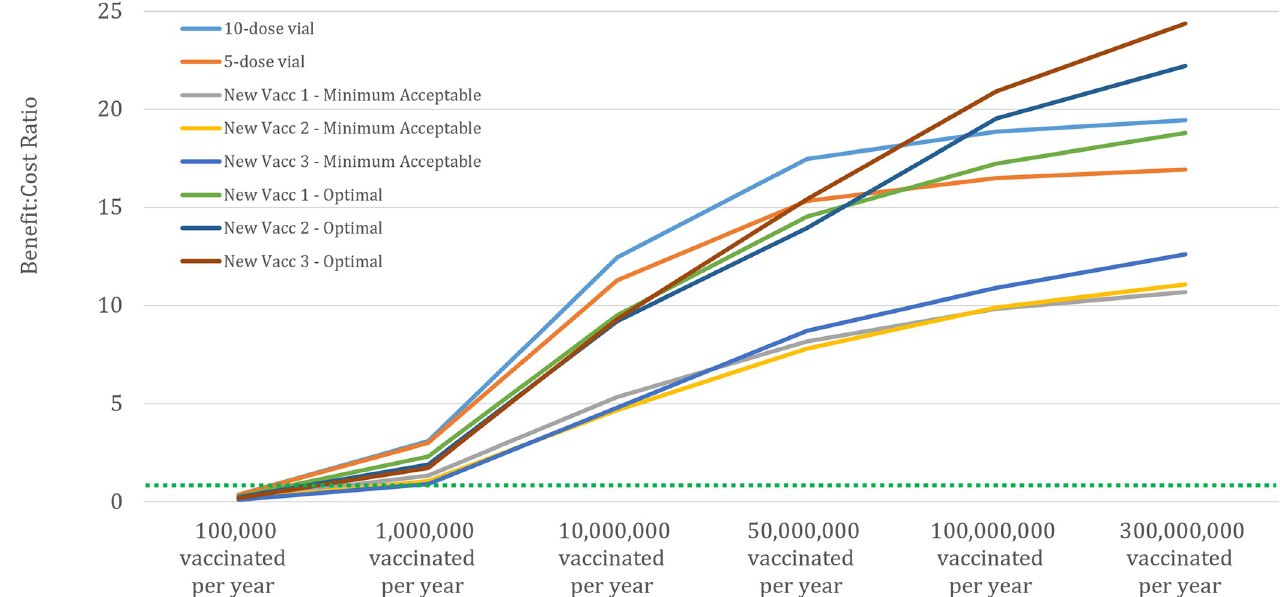
Fig 6. Estimated buyer benefit-cost ratio for each vaccine presentation at different levels of annual demand. The benefit-cost ratio calculations incorporate vaccine purchase price, service delivery costs, wastage, and economic value of vaccination. The green horizontal line corresponds to a ratio of 1, representing the minimum threshold for a “good”